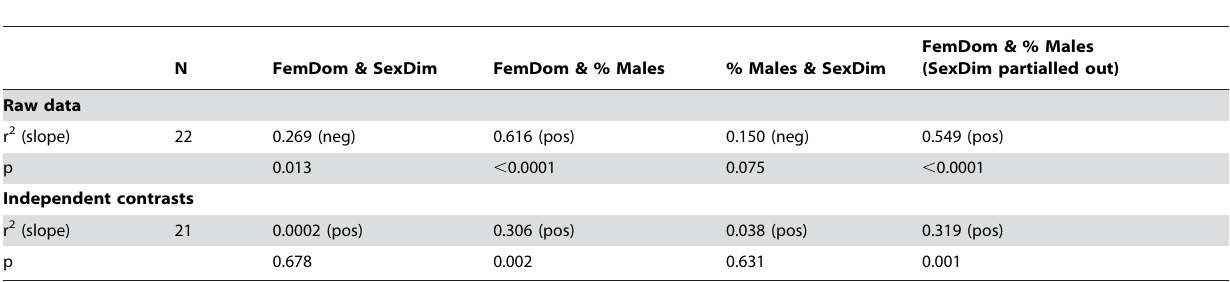
Table 2. Regression analysis of female dominance, sexual dimorphism and percentage of males in the group.